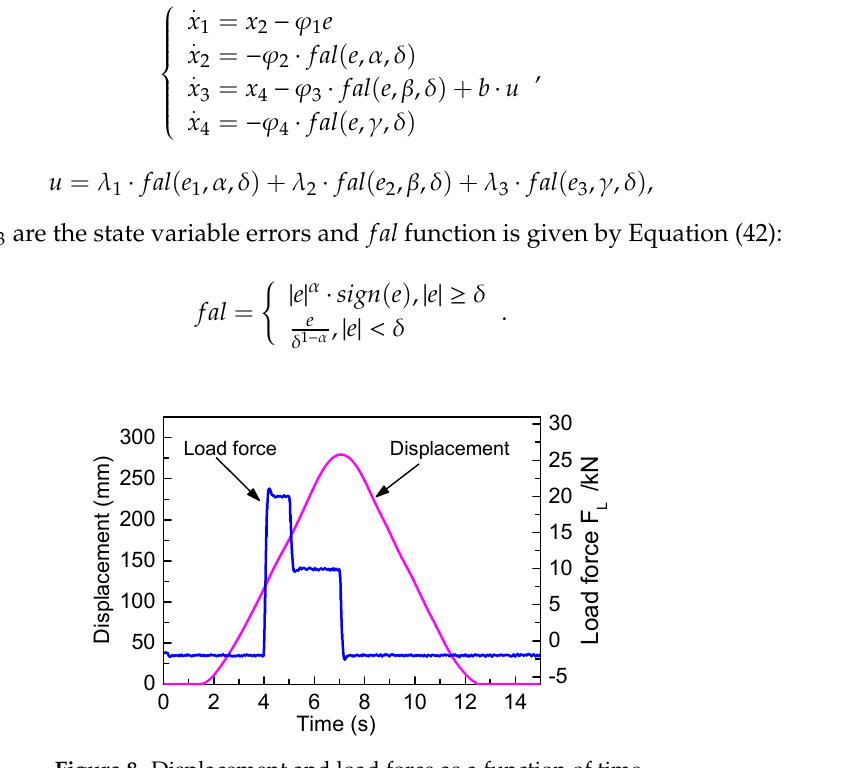
Figure 8. Displacement and load force as a function of time.